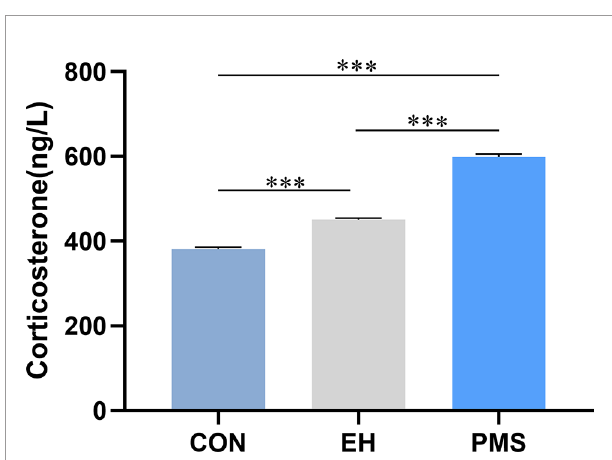
FIGURE 5 | Corticosterone (CORT) in puberty. Levels of circulating plasma CORT were assessed in the control group, EH group and PMS group (CON, EH, PMS) on PND 56. Values are expressed as the mean ± SEM (n= 11 rats per group). ***p <